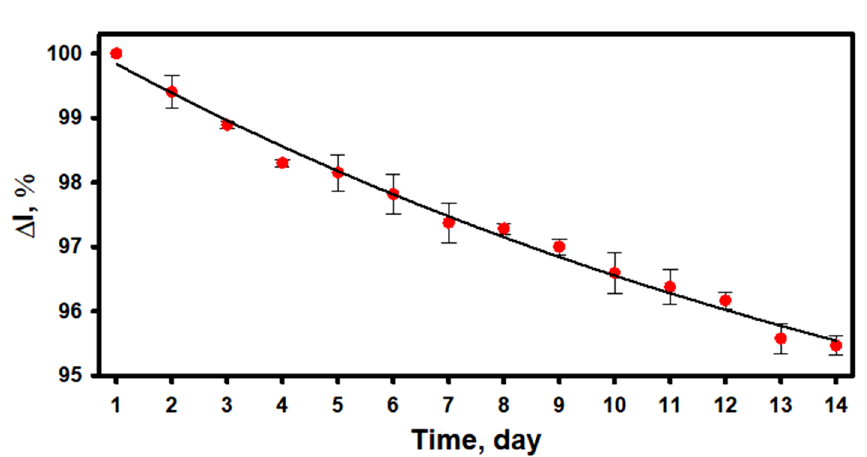
Figure 7. Changes of the biocathode current signal vs time. Measurements conditions: A-PBS-KCl, pH 6.0, 10.0 mM of glucose, applied potential of + 0.1